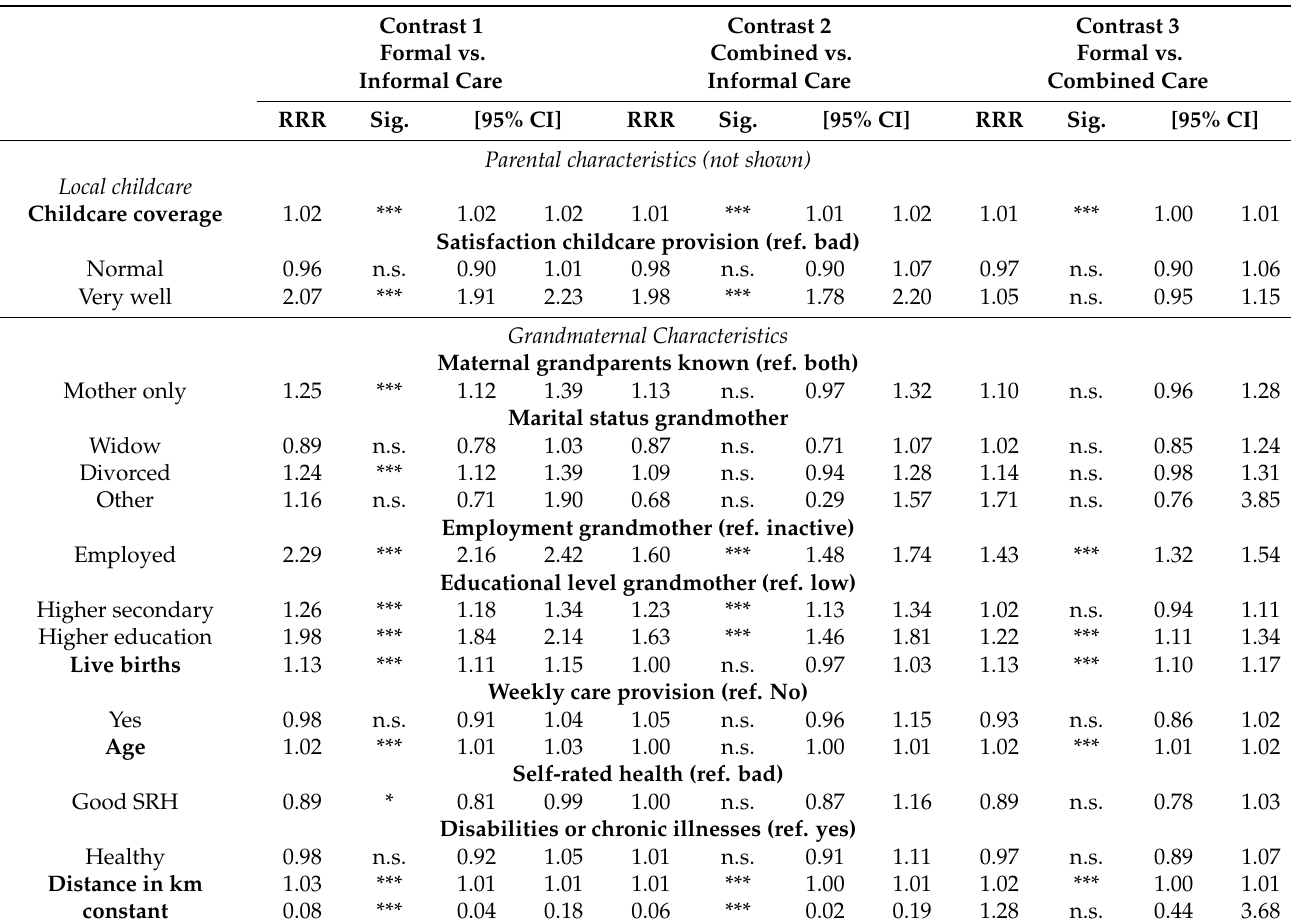
Table 3. Uptake of childcare arrangement by grandmaternal characteristics and formal childcare availability, multinomial logistic regression with different contrasts, relative risk ratios, Belgium, 2001.